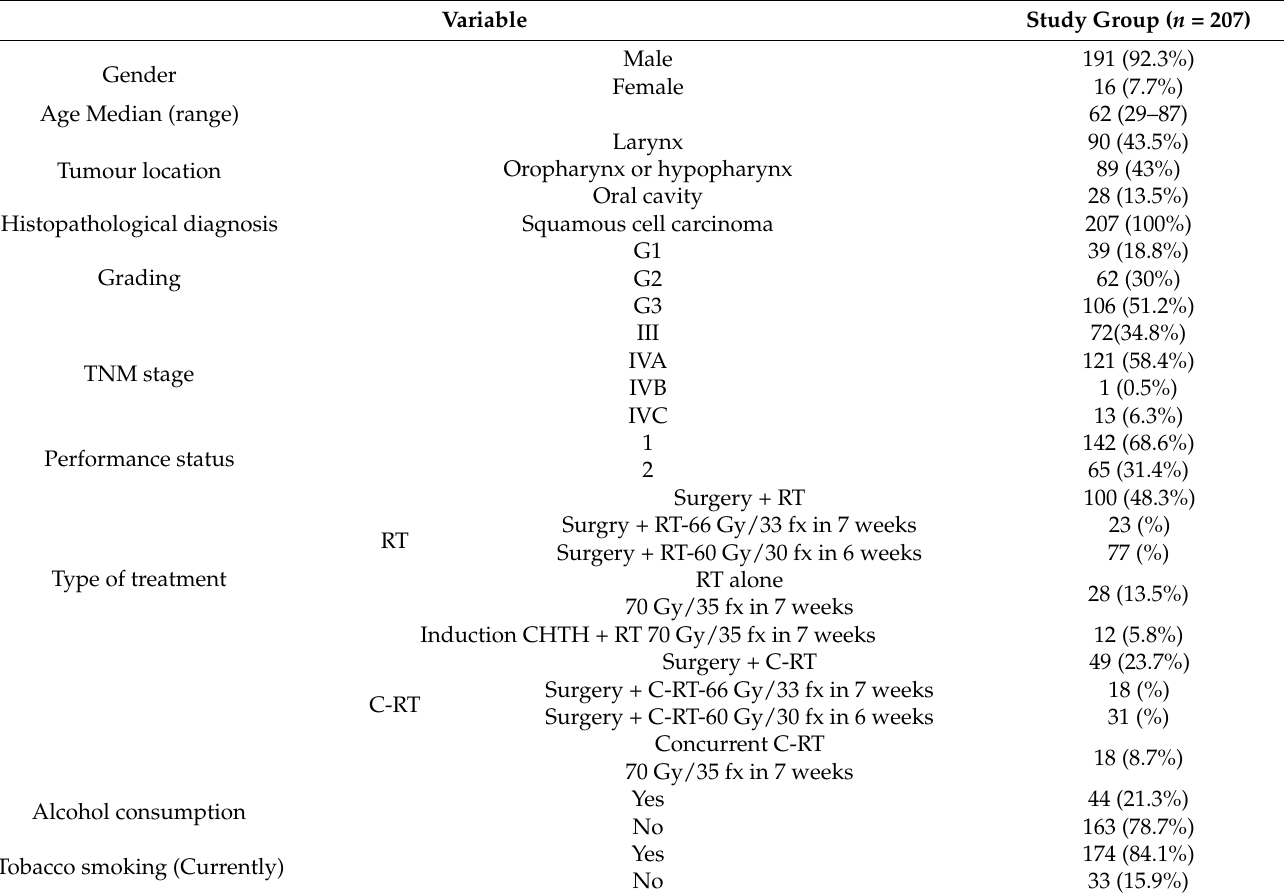
Table 1. Characteristics of the study